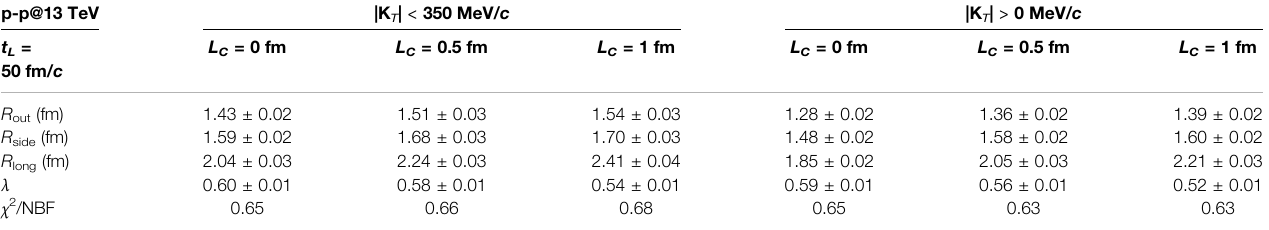
TABLE 3 | Fitted results of HBT radii and λ parameter in Eq. 9 for sources with L C = 0, 0.5, and 1 fm in p-p collisions at 350 MeV/ c and K T > 0 MeV/ c . The t L value is 50 fm/ c , and ratios of χ 2 to the number of bins fi tted are also presented.